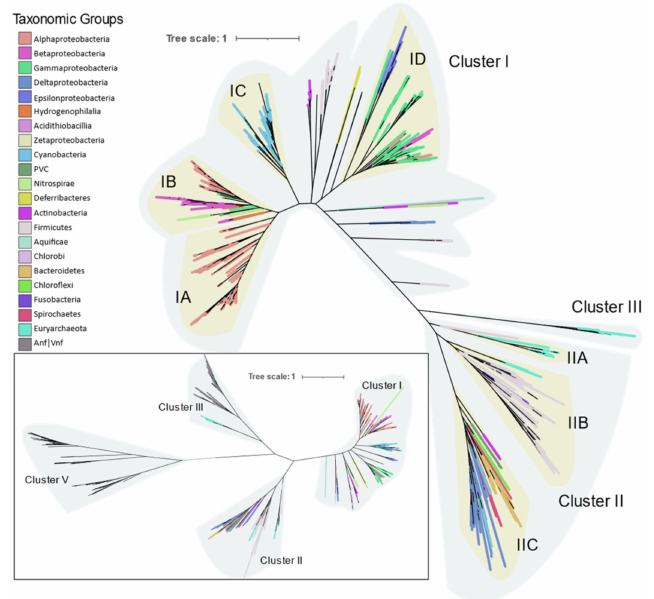
Figure 4. Molecular phylogenetic analysis of concatenated NifHDKENB proteins by FastTree using the JTT+CAT evolution model. Each clade is highlighted by the bacterial or archaeal phylum and Proteobacteria are further divided into classes. Inset: Phylogenetic analysis of the NifHDK protein sequences with concatenated bclLNB as outgroup. All the clusters are labeled as suggested by Raymond